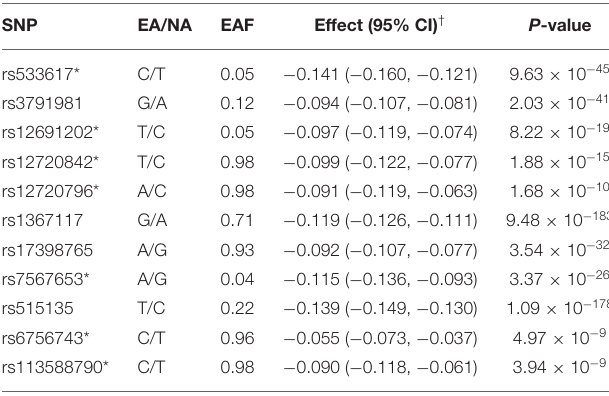
TABLE 1 | Characteristics of LDL Cholesterol-Lowering Genetic Variants within/near HMGCR , NPC1L1 , PCSK9 , LDLR , CETP, and APOB